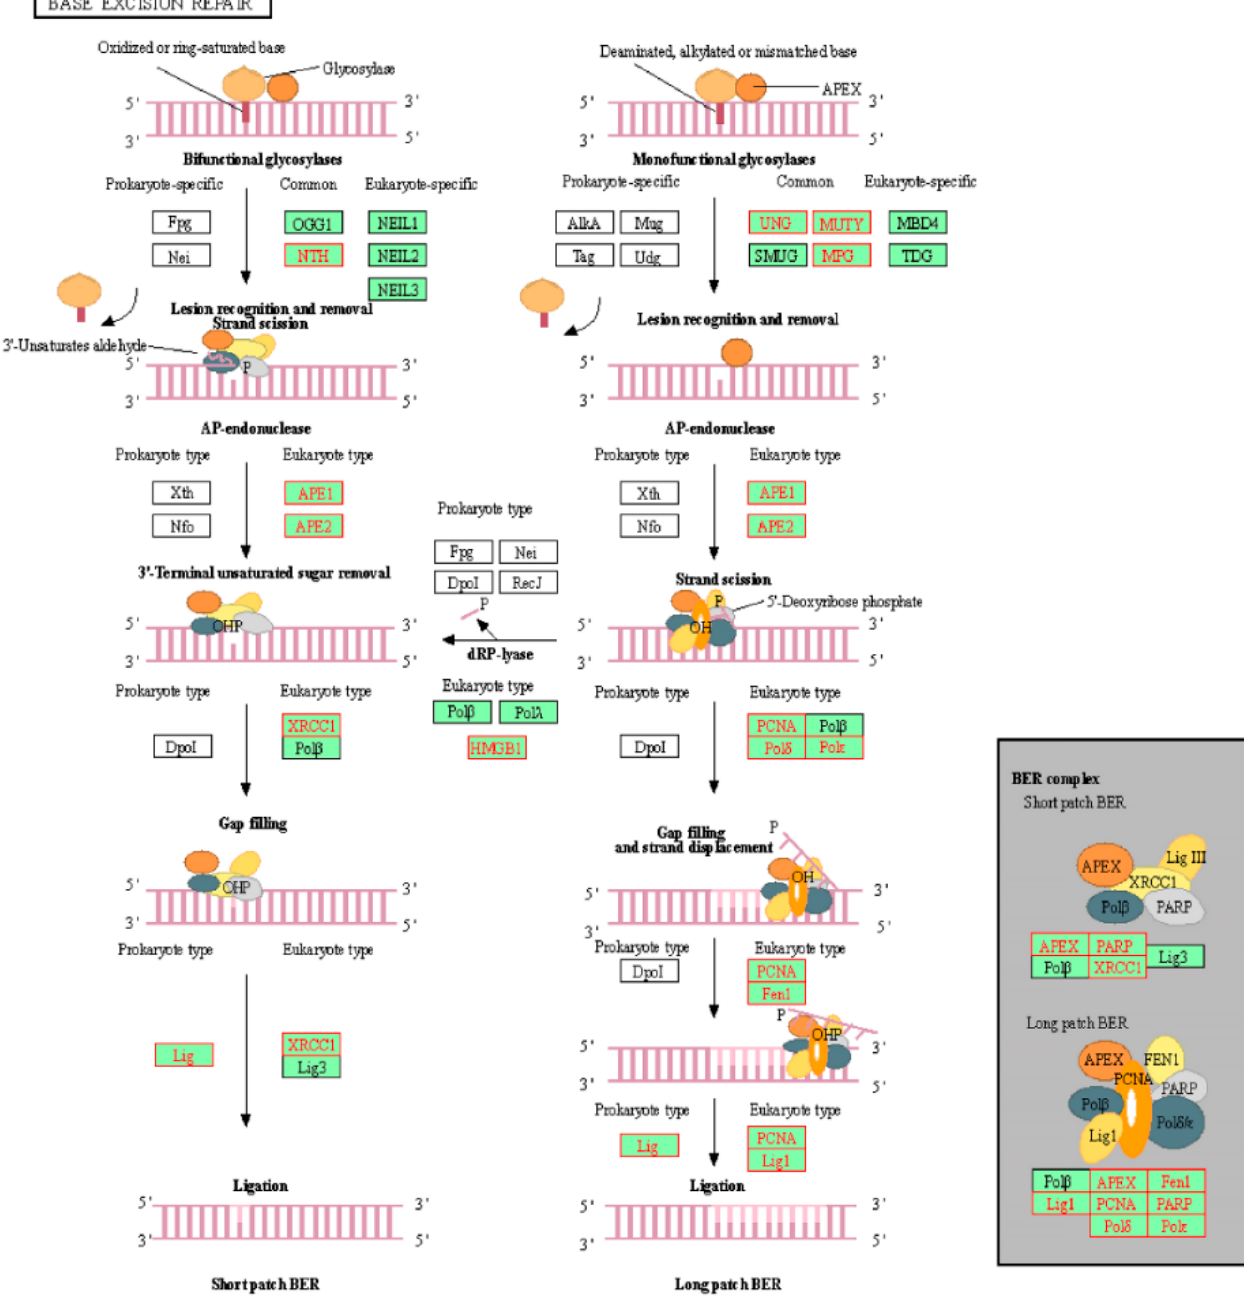
Figure 3. Visualization of the GSEA-enriched genes from the leading-edge subset of the base excision repair pathway in CPT-CEF-treated colon cancer cells. The pathway was extracted from the KEGG database, and the GSEA-enriched genes obtained from the data set were highlighted in red. The underexpression of these genes is predicted to have an impact in the downstream signaling involved during base excision repair.